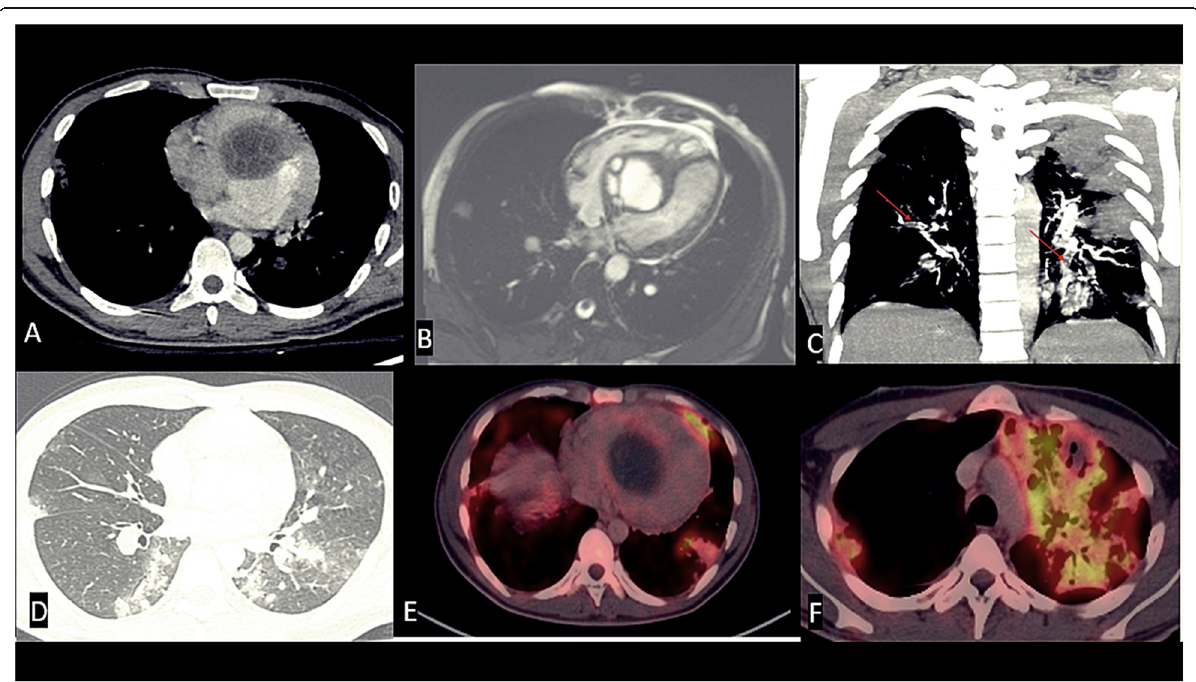
Fig. 2 Contrast-enhanced cardiac CT ( a ), contrast-enhanced cardiac MR ( b ) axial images showing a well-defined, non-enhancing, uncalcified, multivesicular, multiloculated cyst (type II) at interventricular septum. Coronal reformatted CT images ( c , d ) showing segmental and subsegmental intra-pulmonary filling defects in bilateral pulmonary arteries; lung evaluation showing multiple, centri-acinar nodules with “ tree in bud pattern. ” PET CT showing ( e ) no activity at septal cystic mass ( f ) with avid uptake at left upper lobe